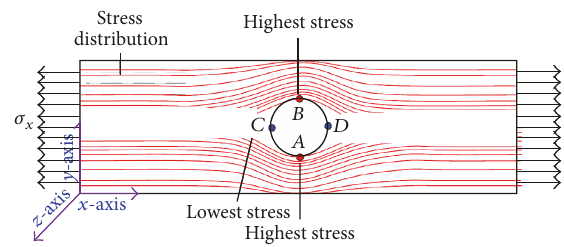
Figure 9: Illustration of stress distribution.